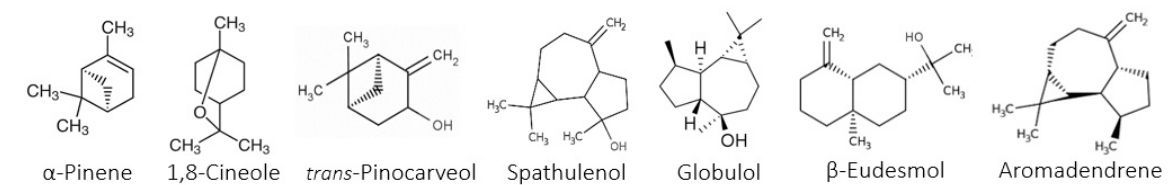
Figure 1. Major compounds of essential oils of E. falcata .